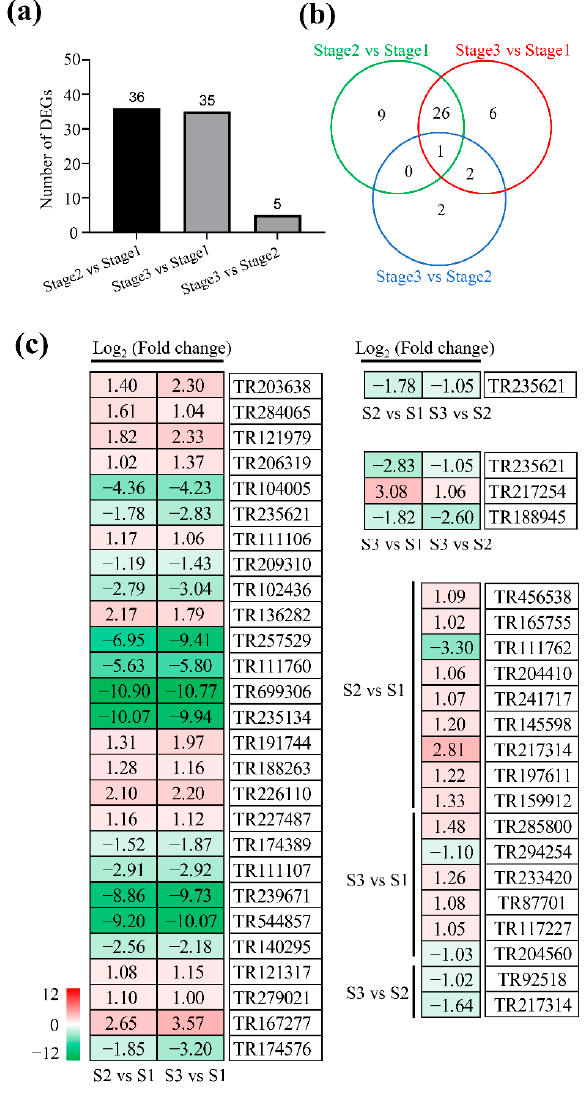
Figure 4. Analysis of differentially expressed genes involved in carbohydrate metabolism. ( a , b ) Summary of differentially expressed genes at stage 1, stage 2, and stage 3. ( c ) The list of differentially expressed genes. Red and green represent up-regulated and down-regulated,